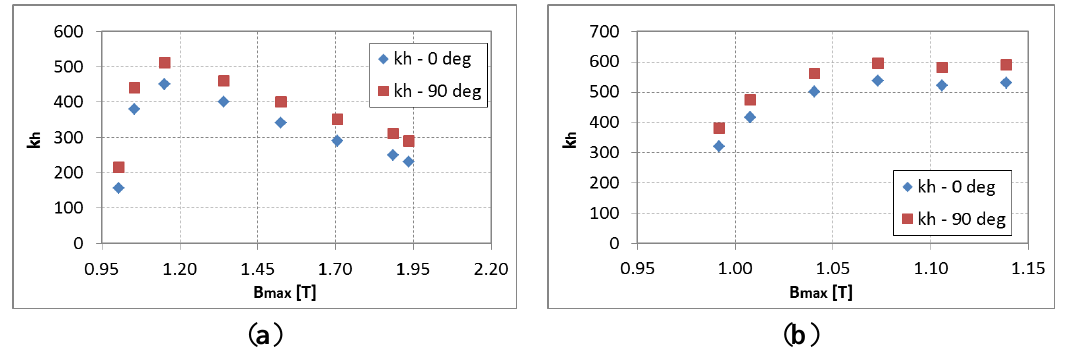
parameter identification at ( a ) 50 Hz and ( b ) 600 Hz h